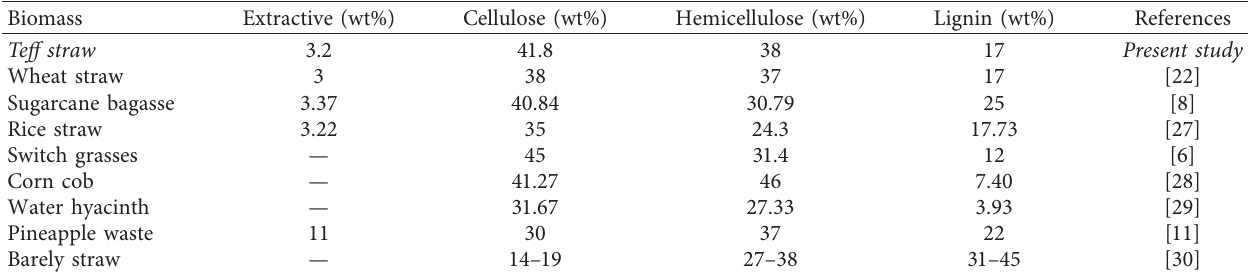
Table 4: Results for chemical composition analysis of Teff straw compared with other biomass